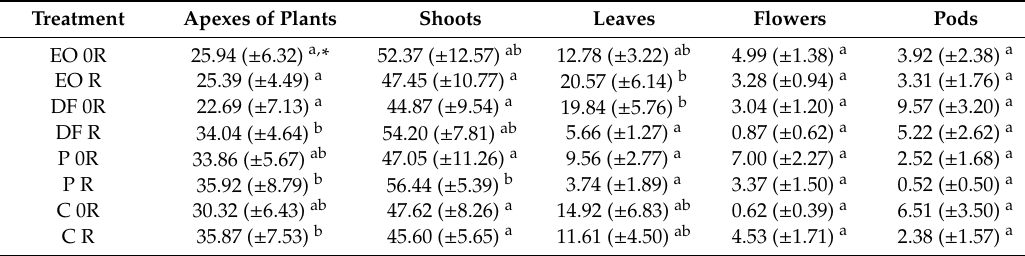
Table 2. The e ff ect of petroleum-derived substances and ZB-01 biopreparation on the position of Aphis fabae Scop. colonies (% of the total number of aphids) (average in the research season).